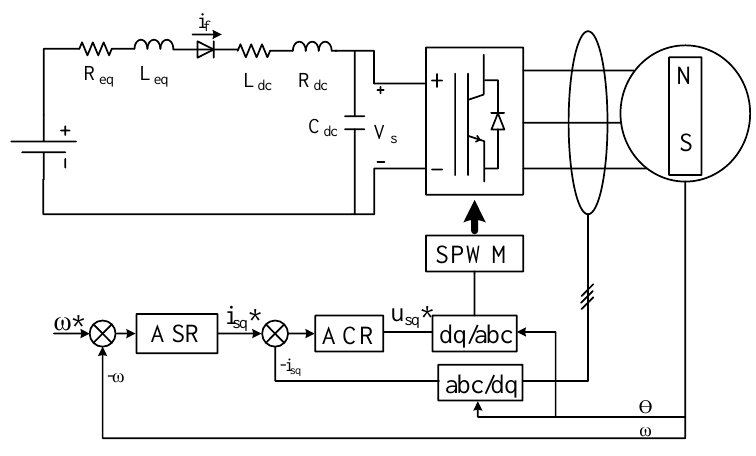
Figure 9. Simulation schematic based on PMSM.